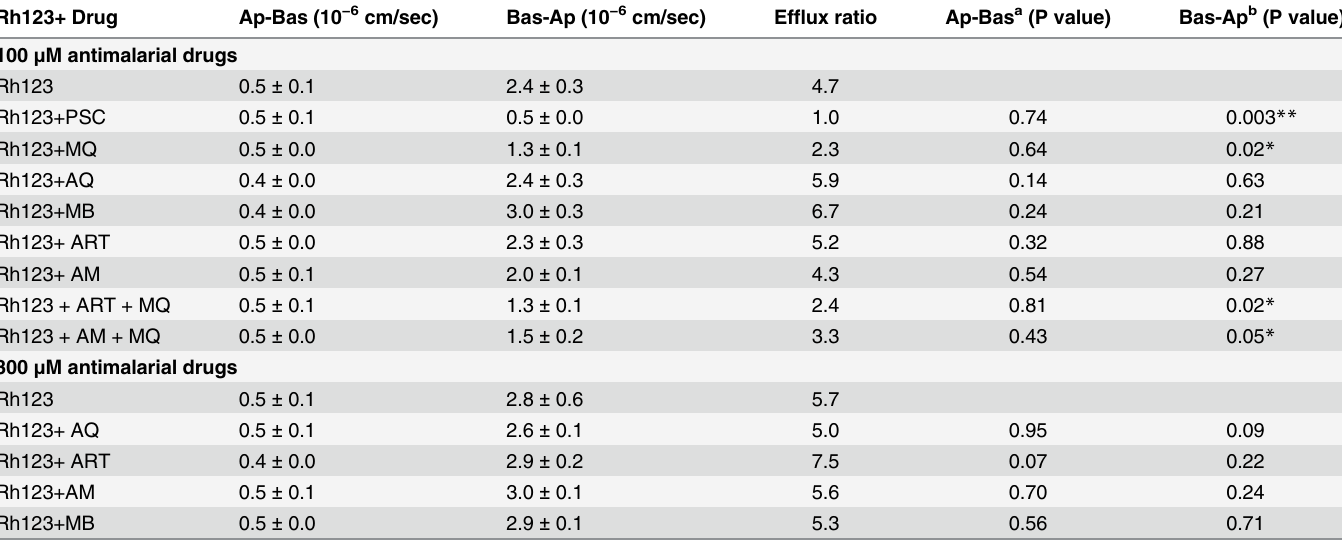
Table 1. Apparent permeability (P app ) and efflux ratio for 5 μ M rh123 through Caco-2 cell monolayers when co-incubated with selected antimalarial drugs. Rh123+